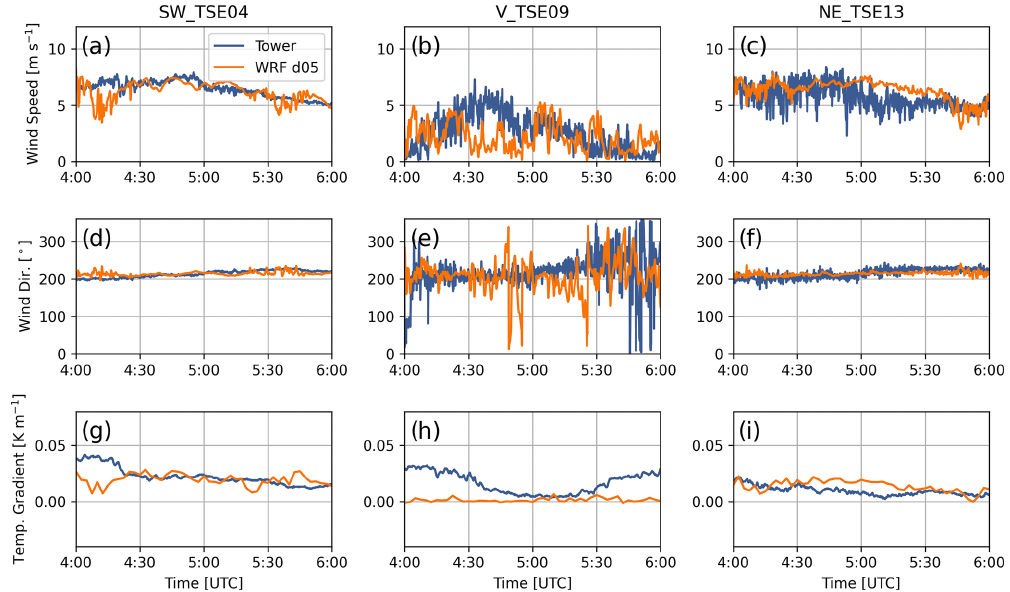
Figure 7. Comparison between meteorological tower data and WRF–LES–GAD d05 for 80m wind speed (a–c) , 80m wind direction (d–f) , and 100–10m temperature gradient (g–i) for the stable case study. SW_TSE04 and NE_TSE13 are located on ridges, while V_TSE09 is located in the valley. Note that the model wind speed and direction are output at 10s intervals, while the temperature is output every 150s. Table 2. Wind speed, wind direction, and temperature gradient bias and RMSE between WRF–LES–GAD and meteorological tower mea- surements for the stable case study. SW_TSE04